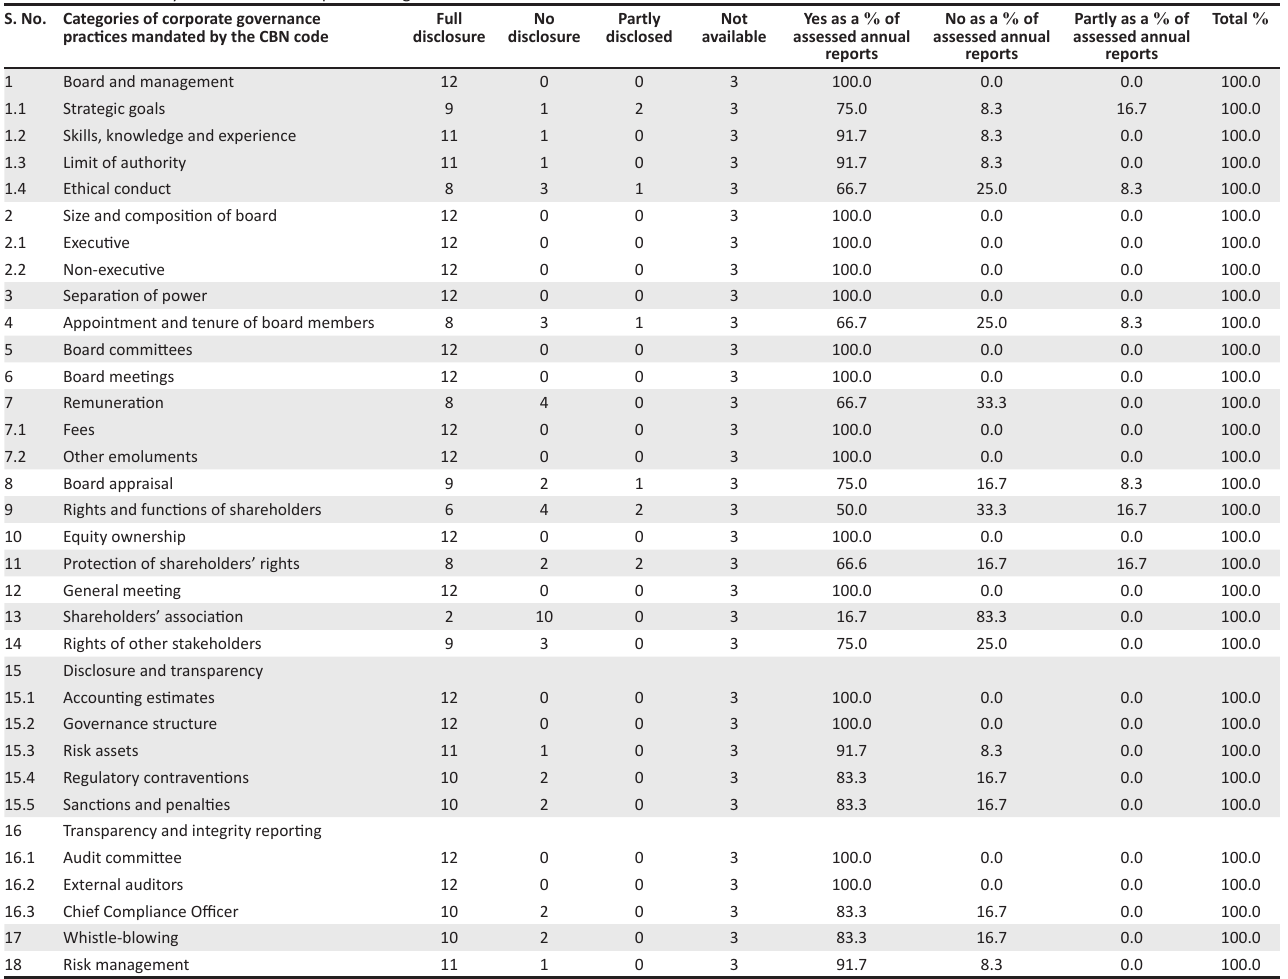
TABLE 3: Content analysis: 2014 annual reports of Nigerian banks. S. No. Categories of corporate governance practices mandated by the CBN